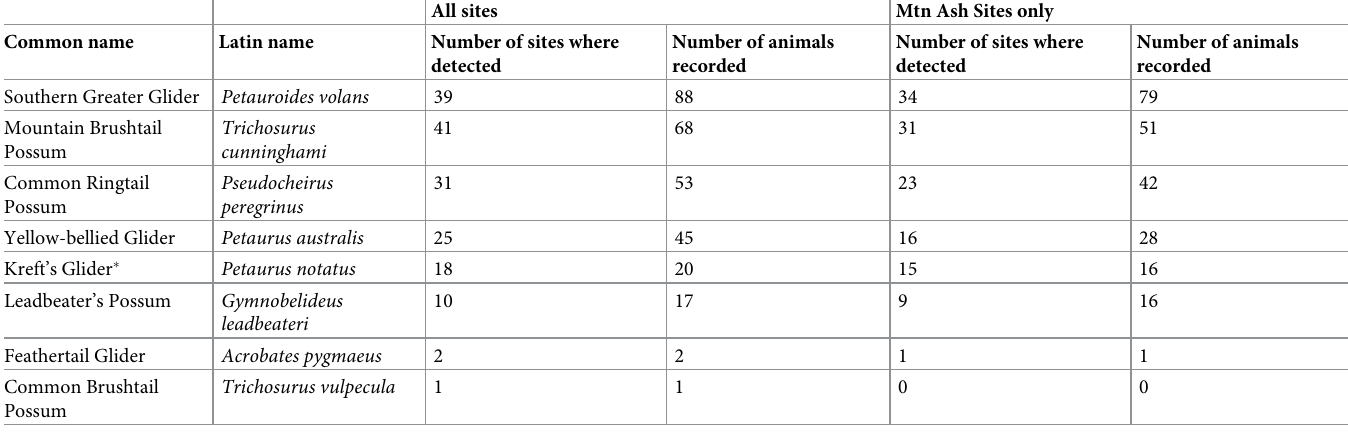
Table 1. Numbers of individuals and sites at which different species of arboreal marsupials were detected. We have listed species in order of detection frequency. All sites Mtn Ash Sites